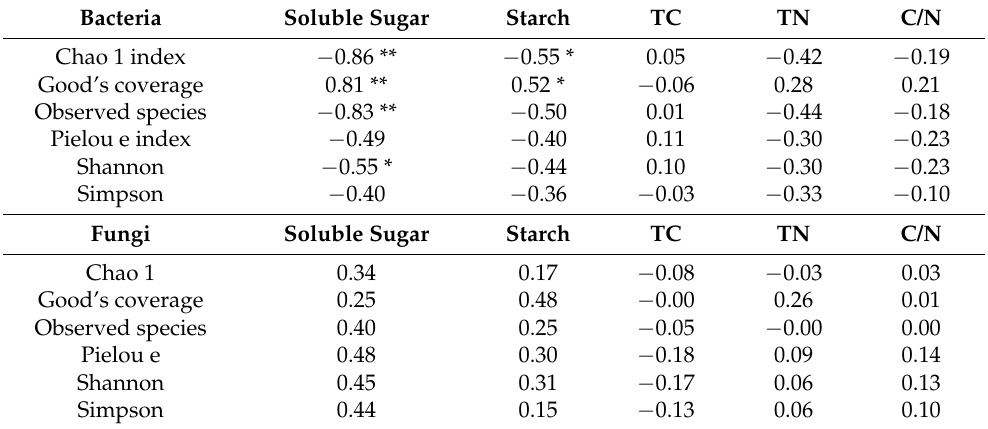
Table 3. The relationships between leaf characteristics and phyllosphere microbial community diversity.